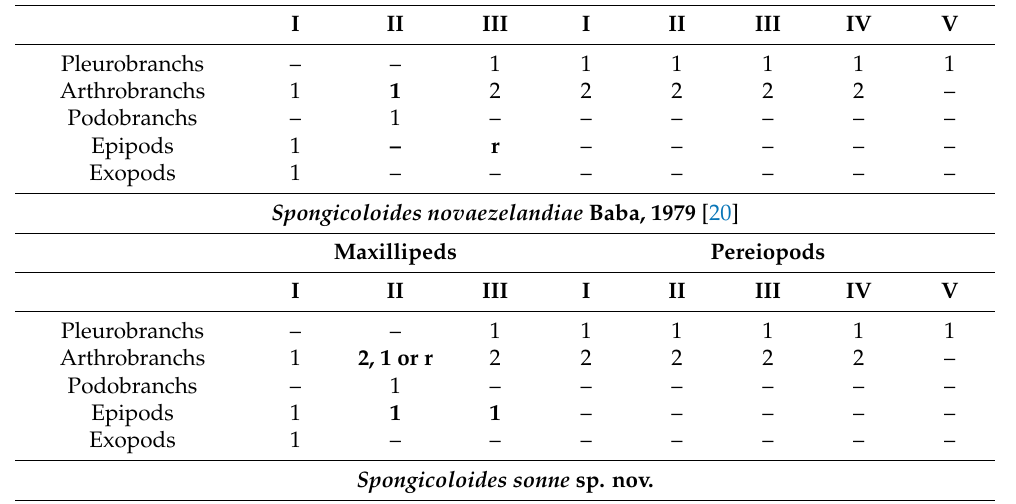
Table 2. Branchial formulae of New Zealand species of Spongicoloides and Spongiocaris (r = rudimentary). Spongicoloides clarki sp. nov.